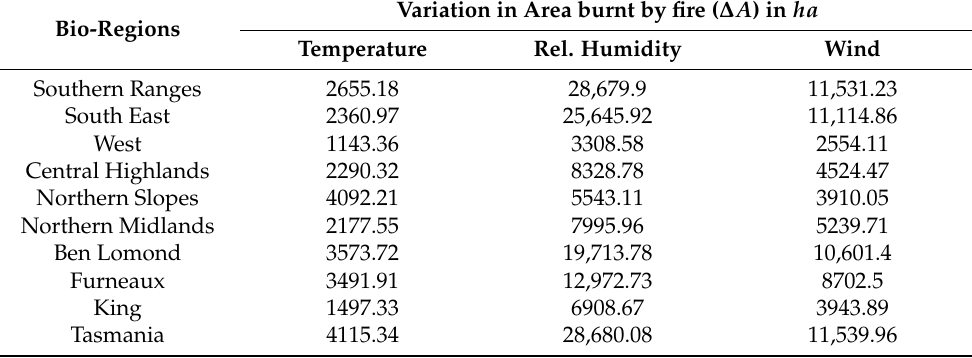
Table 1. Variability in fire area caused by variability in input